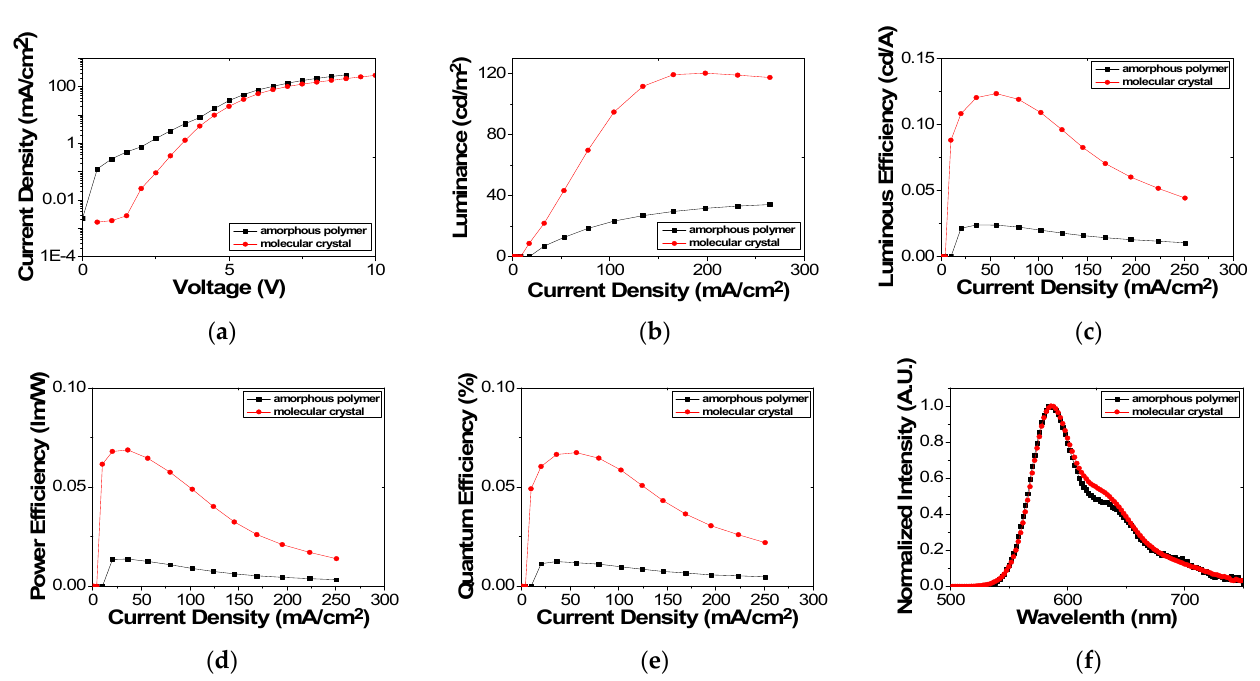
Table 1. The measured electro-optical characteristics of OLED device fabricated by amorphous polymer and molecular crystal.